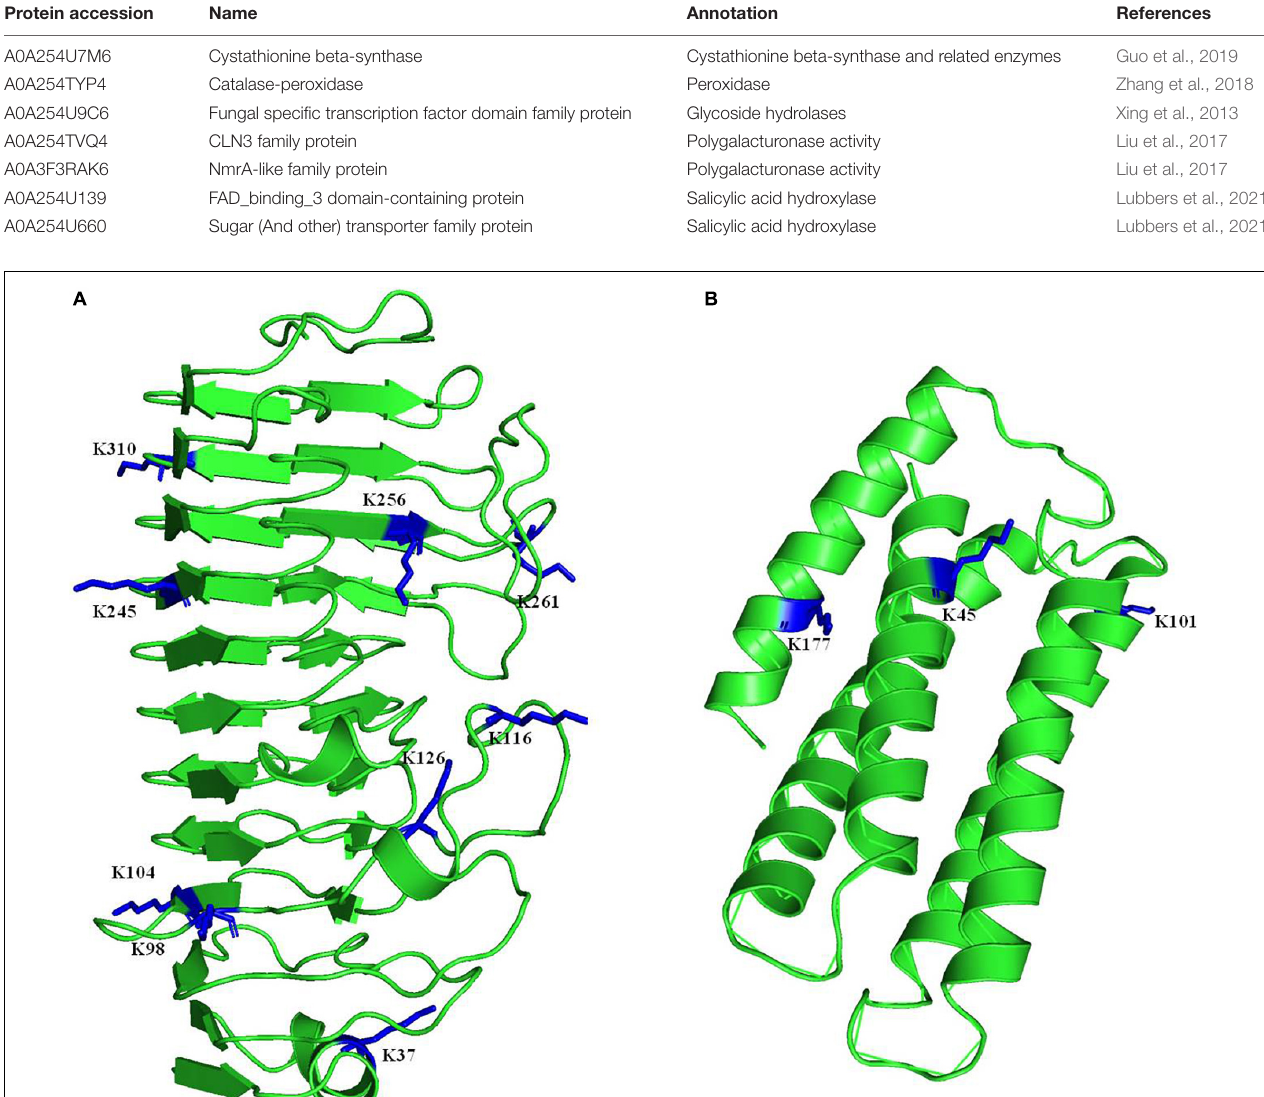
FIGURE 6 | Three-dimensional structure of two proteins that involved in pathogenesis in A. niger with identified Khib site. (A) The polygalacturonase activity enzyme. (B) The Glycoside hydrolases enzyme. The structure was taken from PDB database. The identified sites were highlighted in